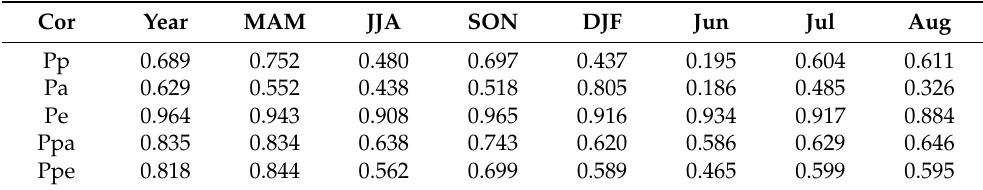
Figure 9. Diurnal changes in precipitation rate (mm/hr) between the two decades. Table 3. Correlation coefficients of precipitation difference with precipitation probability (Pp), after- noon precipitation difference (Pa), nighttime precipitation difference (Pe), afternoon precipitation frequency difference (Ppa) and nighttime precipitation frequency difference (Ppe).